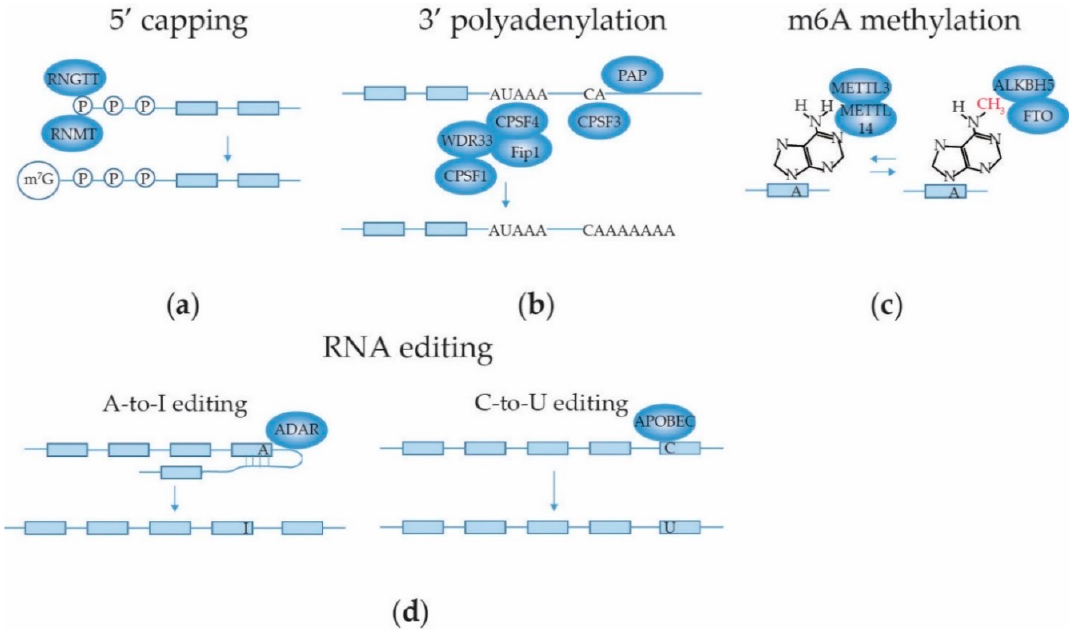
Figure 5. Illustration of other (pre-)mRNA processing activities performed in the supraspliceosome simultaneous with pre-mRNA splicing. ( a ) 5 ′ capping, ( b ) 3 ′ polyadenylation, ( c ) m6A methylation, ( d ) A-to-I and C-to-U RNA base editing. Details are given in the main text.